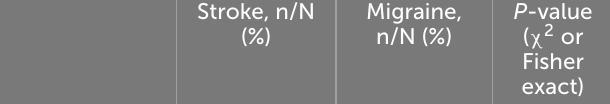
TABLE 4 Time lapse between symptoms in ischemic stroke and migraine